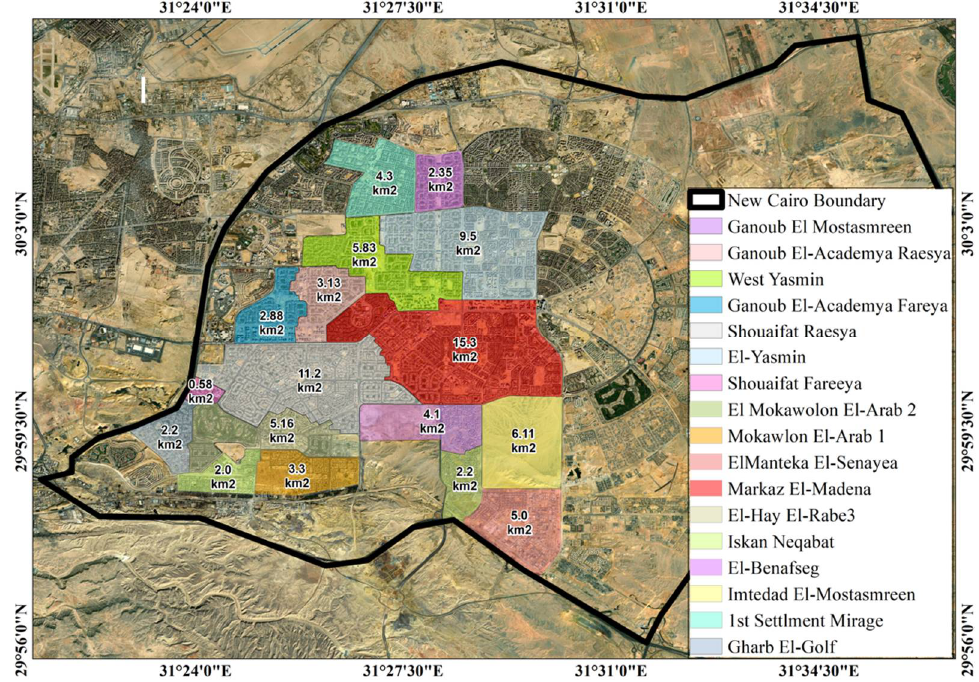
Figure 3. New Cairo’s 17 neighborhoods included in the study showing their locations and areas (km 2 ).